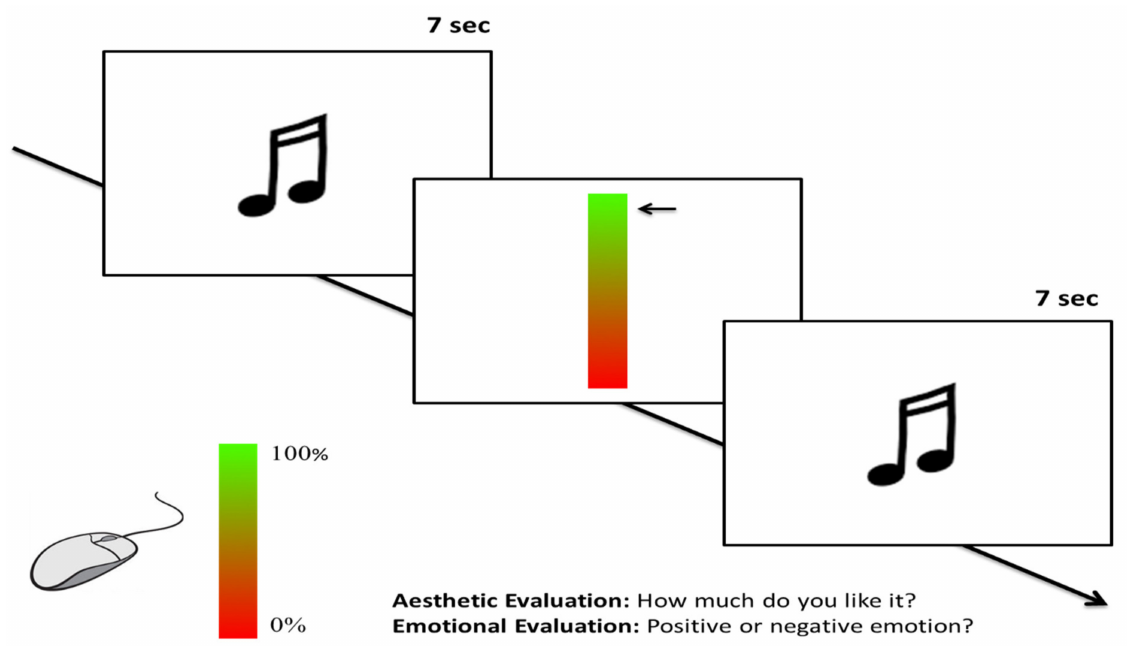
Figure 1. Example of an experimental trial. In each trial, an excerpt was presented while the screen was totally white. The participants’ task was to indicate, by moving the mouse cursor along a rating bar, how much they liked the track (esthetic evaluation) or how much they felt a positive or negative emotion (emotional evaluation). The lower red end of the rating bar corresponded to 0% score (i.e., “I do not like it at all”/“entirely negative emotion”). The upper green end of the rating bar corresponded to 100% score (“I entirely like it”/“entirely positive emotion”). The bar remained visible until participants expressed their judgment. Then, after 300 ms, a new track was